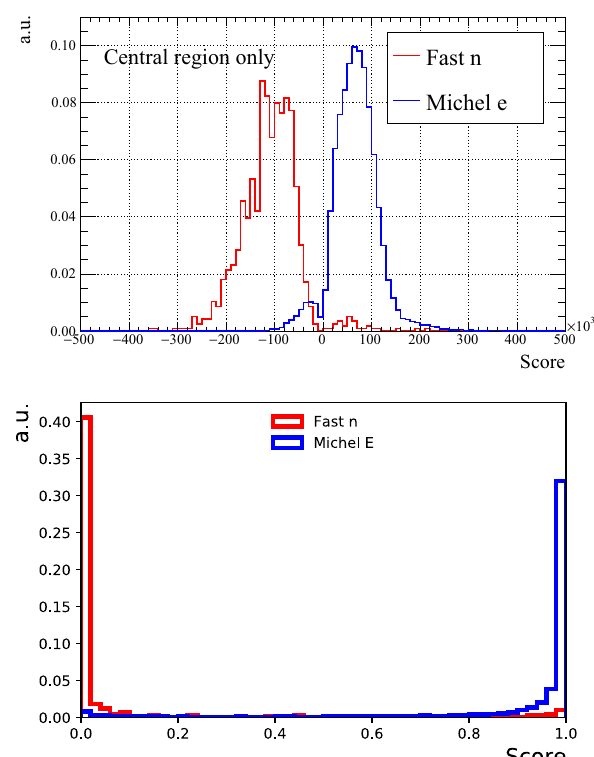
Fig. 3 Top: the likelihood score distributions of the Michel electron sample (blue) and the fast neutron sample (red). The Michel electron sample represents the distribution of the neutrino signal. Bottom: the CNN score distributions of the Michel electron sample (blue) and the fast neutron sample (red). The label “Central region only” indicates that the event vertices around the detector center ( r < 60 cm and | z | < 60 cm) are used